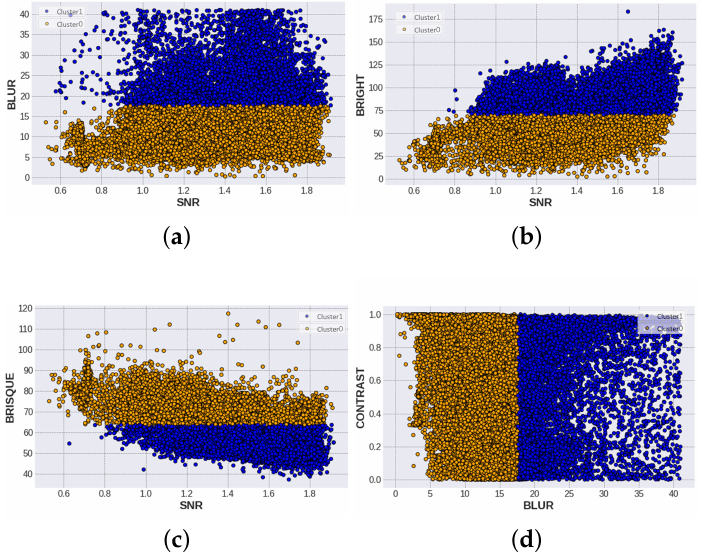
Figure 10. Comparison of standard features according to their cluster label, cluster 0 and cluster 1. ( a ) SNR vs BLUR comparison with a separation value ≈ 17 in BLUR. ( b ) SNR vs BRIGHTNESS comparison with value ≈ 75 in BRIGHTESS. ( c ) SNR vs BRISQUE division ≈ 65 in BRISQUE. ( d ) BLUR vs CONTRAST with threshold ≈ 17 in BLUR. Table 5. Distribution of data sources. The K-labels are generated by KMeans clustering. Dataset Images K0 K1 EyePACS